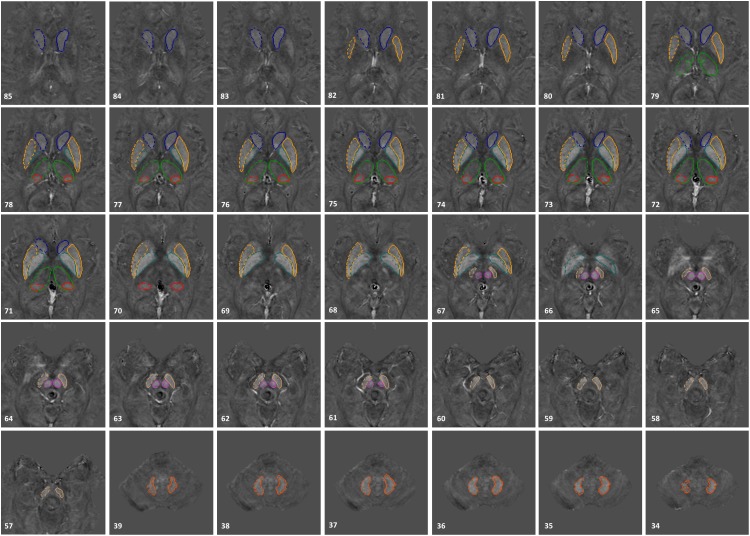
3D regions of interest (ROIs) traced on susceptibility maps of a 65-year-old male. Structures include the head of caudate nucleus (CN), globus pallidus (GP), putamen (PUT), thalamus (THA), pulvinar thalamus (PT), red nucleus (RN), substantia nigra (SN), and dentate nucleus (DN). The numbers in the lower left corner represent the slice numbers from 132 slices collected in this example.